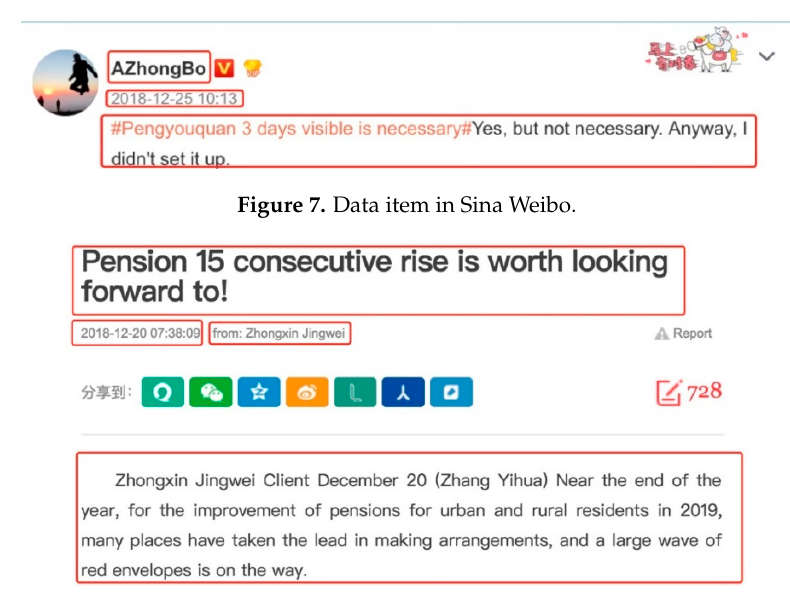
Figure 8. Data item in Netease News.